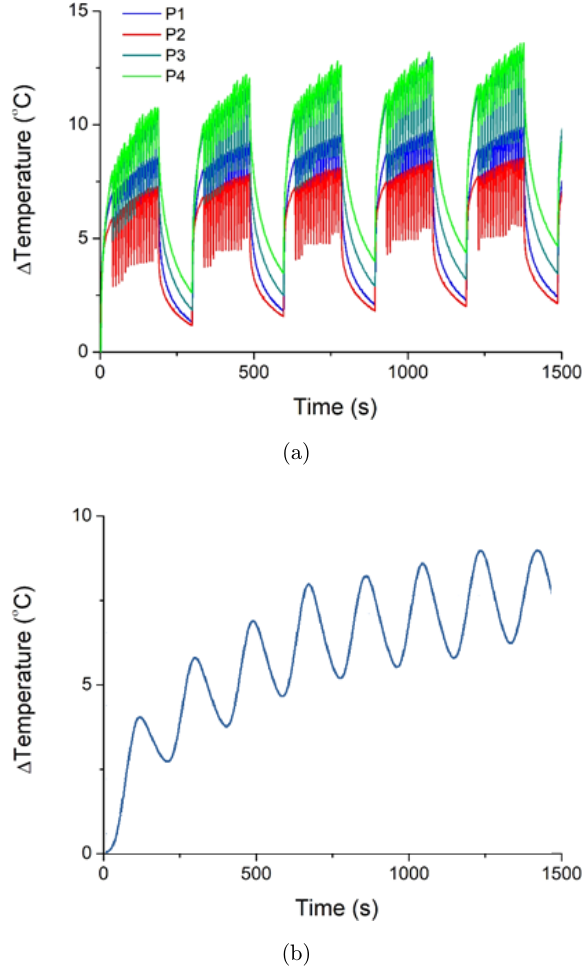
Fig. 7. Temperature distribution inside the tissue phantom visualized using a thermal imaging camera. The compositions of the agar gel layers are (a) P1, (b) P2, (c) P3 and (d) P4, as listed in Table 1.